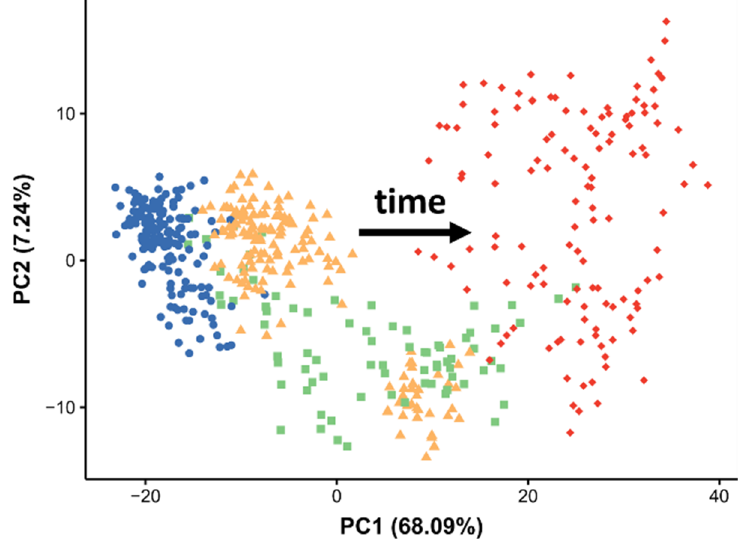
Figure 5. PCA scores plot from analysis of the DESI-MS dataset of unexposed Daphnia magna eggs across the seventh adult instar—specifically 8 (blue circles), 24 (yellow triangles), 48 (green squares), and 72 h (red diamonds) after the sixth brood. Each point relates to a single pixel from a DESI-MS ion image of D. magna egg.